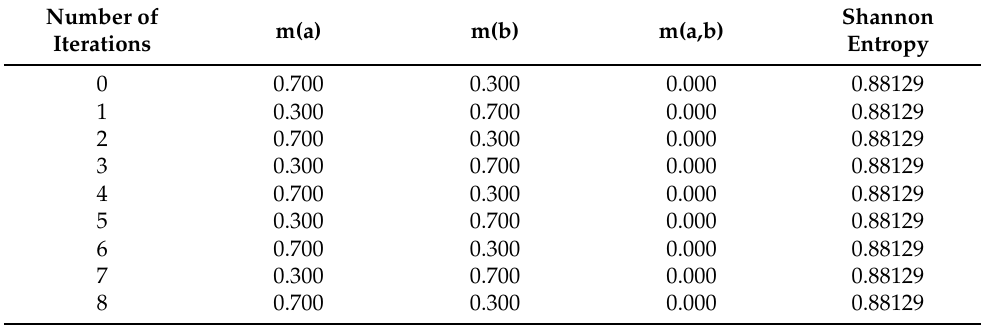
Table 1. BPA and entropy after Yin’s negation iterations in Example